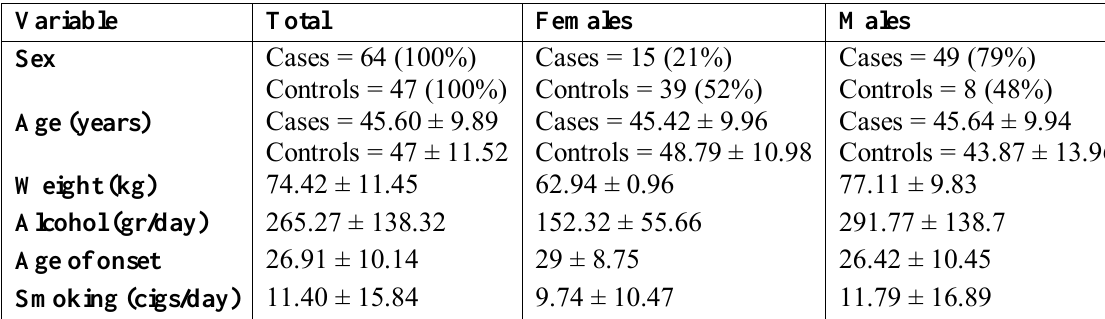
Table 1. Demographic data of patients.